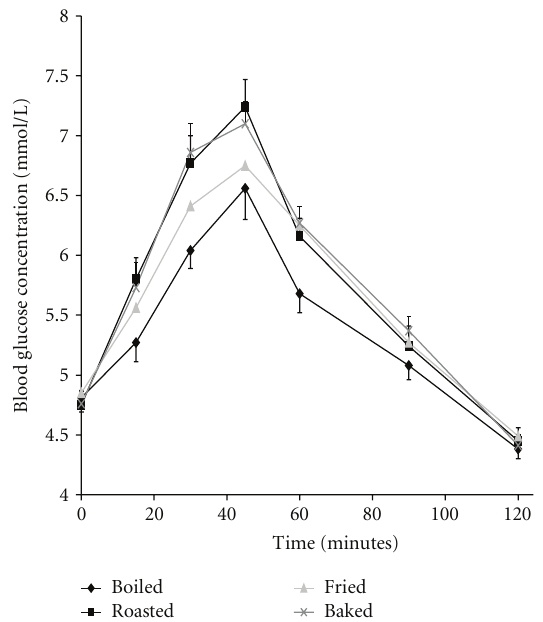
Figure 1: Mean glycemic responses elicited by 50 g available carbo- hydrate portions of all ten sweet potato cultivars processed by boil- ing (solid diamond), baking (x), roasting (solid square), and frying (gray